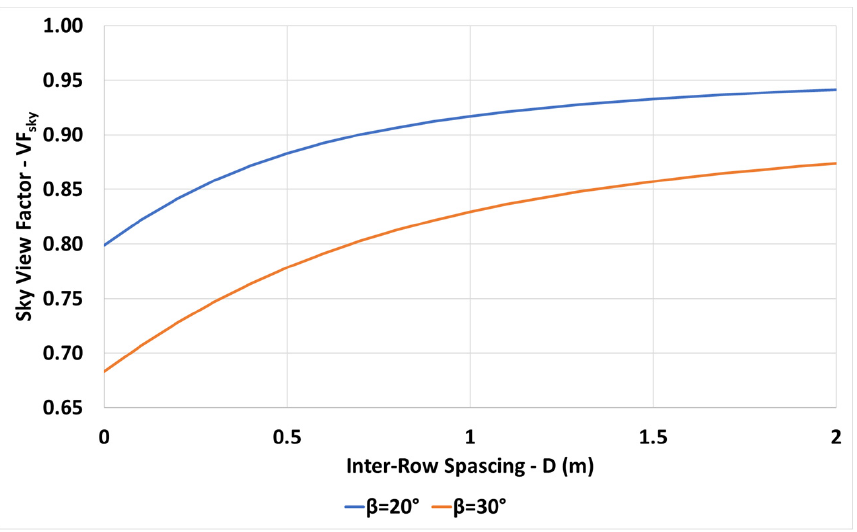
Figure 15. Variation of the sky view factor in a multiple row PV deployment.